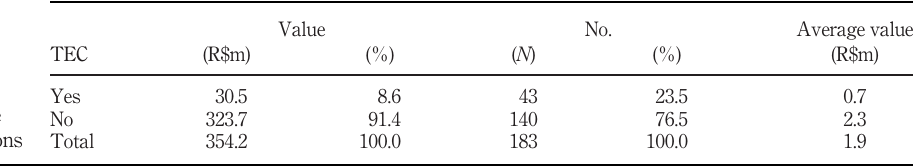
Table VII. Use of TEC in the observed